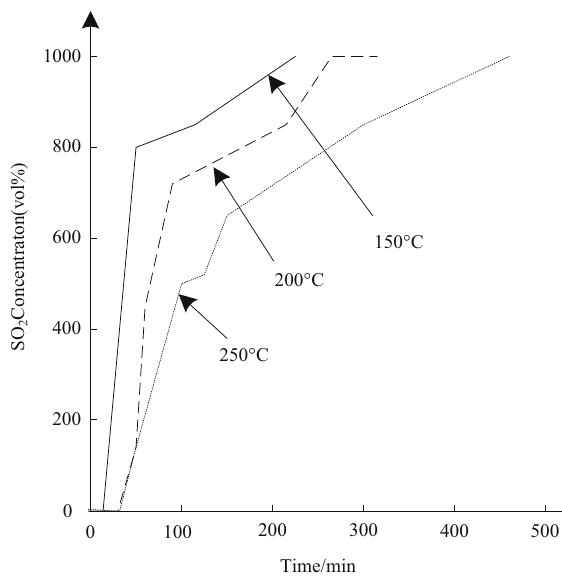
Figure 5: Desulfurization curve of absorption liquid at di ff erent temperatures.